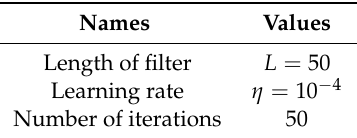
Table 1. Parameters of the proposed ICA